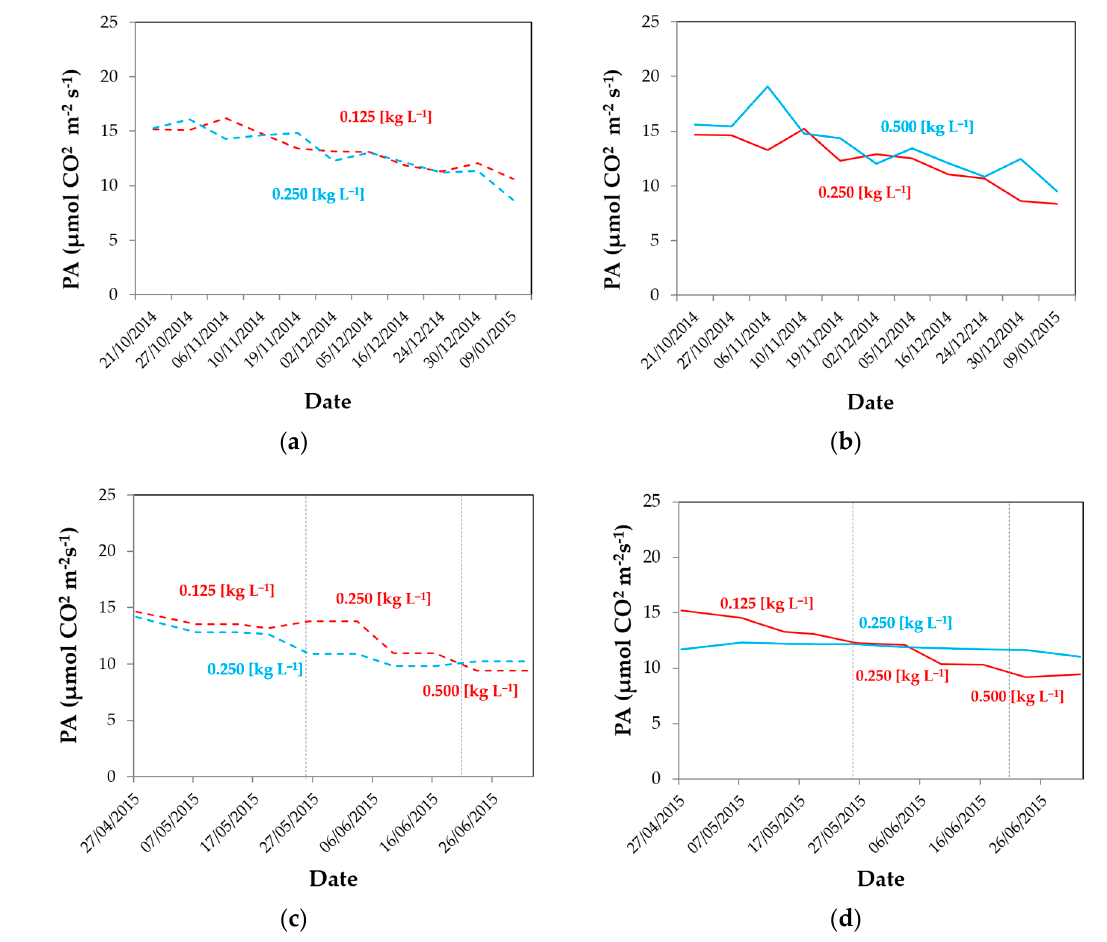
Figure 6. Evolution of photosynthetic activity PAR in the autumn–winter crop cycle ( a , b ) and the spring–summer crop cycle ( c , d ). West sector in greenhouses 1 (- - -) and 2 (—-) with the control concentration of 0.250 kg L − 1 in both crop cycles and east sector in greenhouses 1 (- - -) and 2 (—) with different doses. Date of the change of dose in the variable treatment (·····).